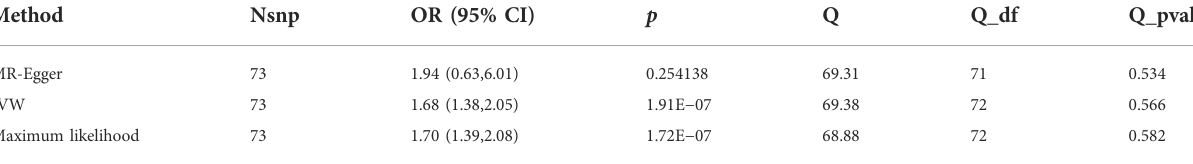
TABLE 2 Heterogeneity test of MR